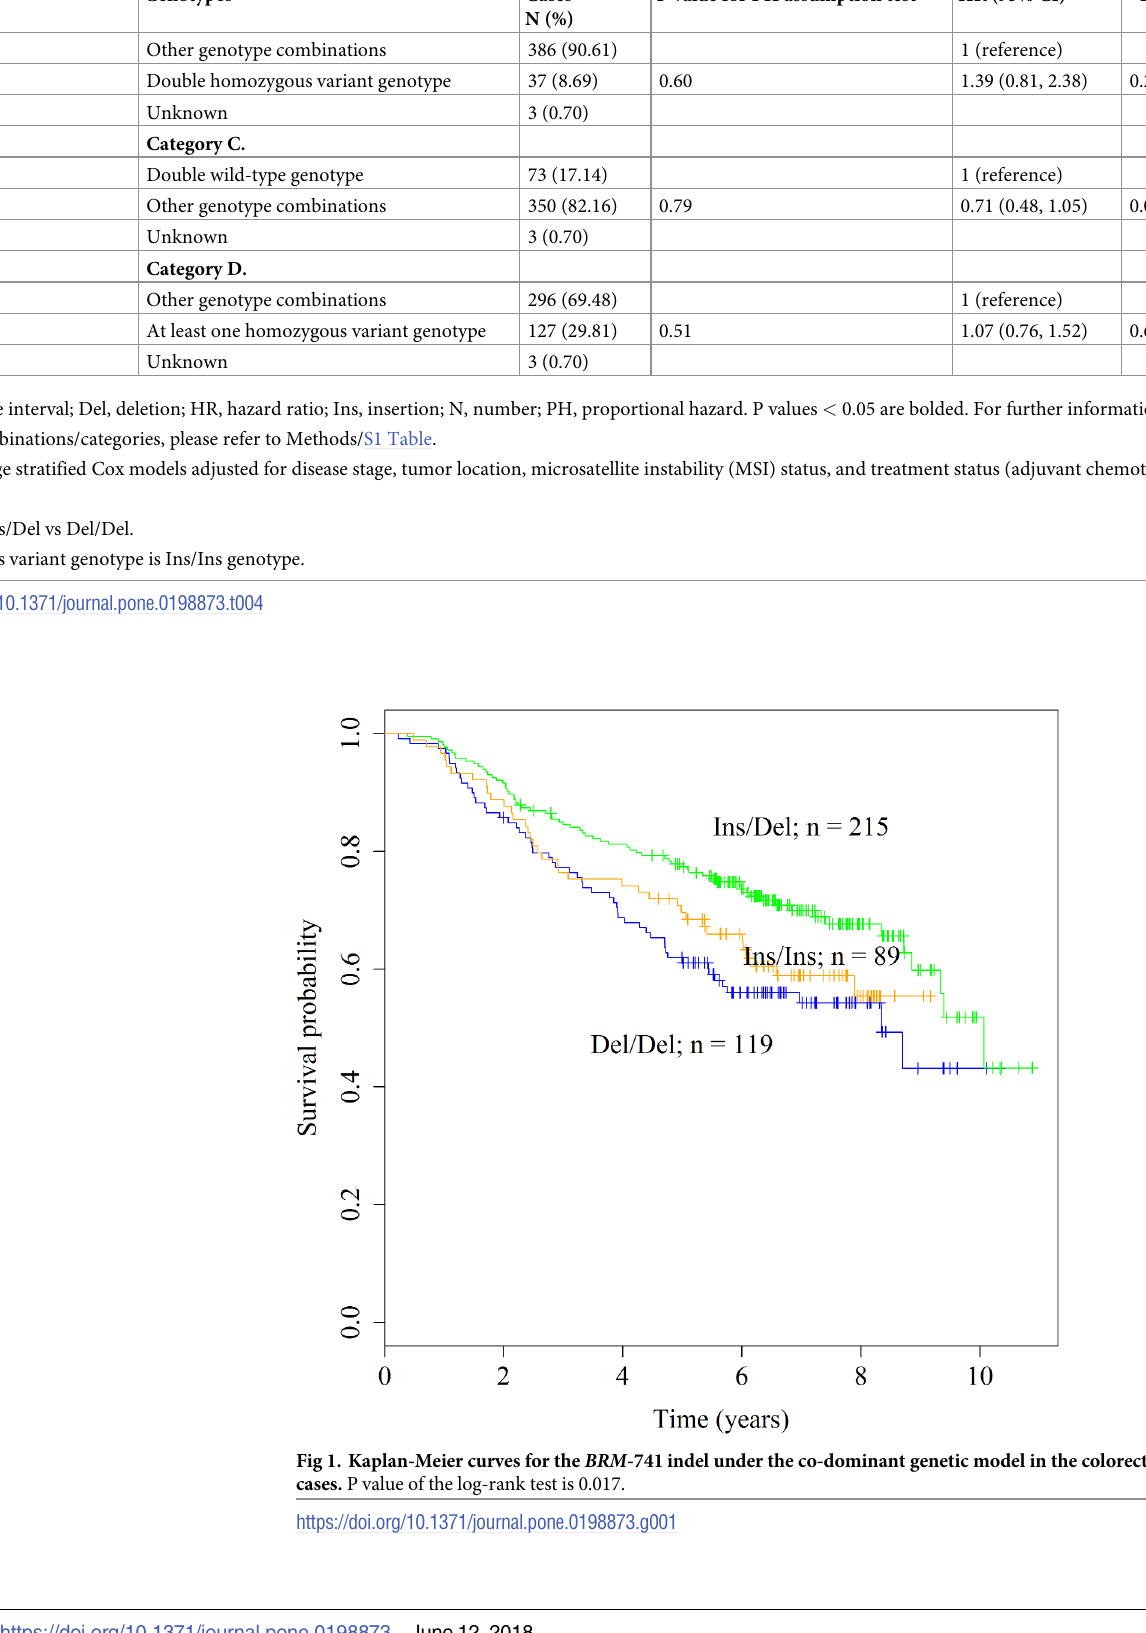
PLOS ONE | https://doi.org/10.1371/journal.pone.0198873 June 12,